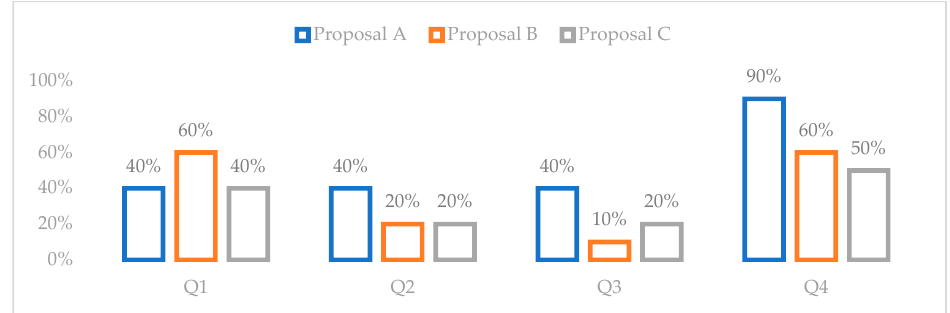
Figure 15. Differences were observed in terms of choosing the Circular line.